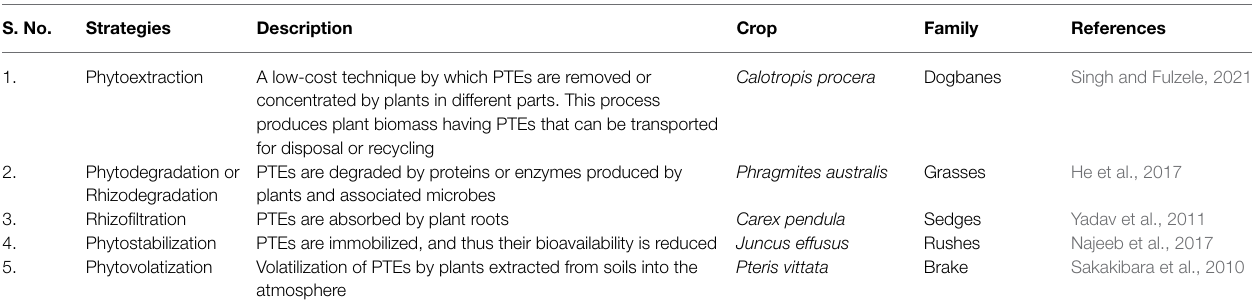
TABLE 1 | Phytoremediation strategies adopted in response to PTEs. S.